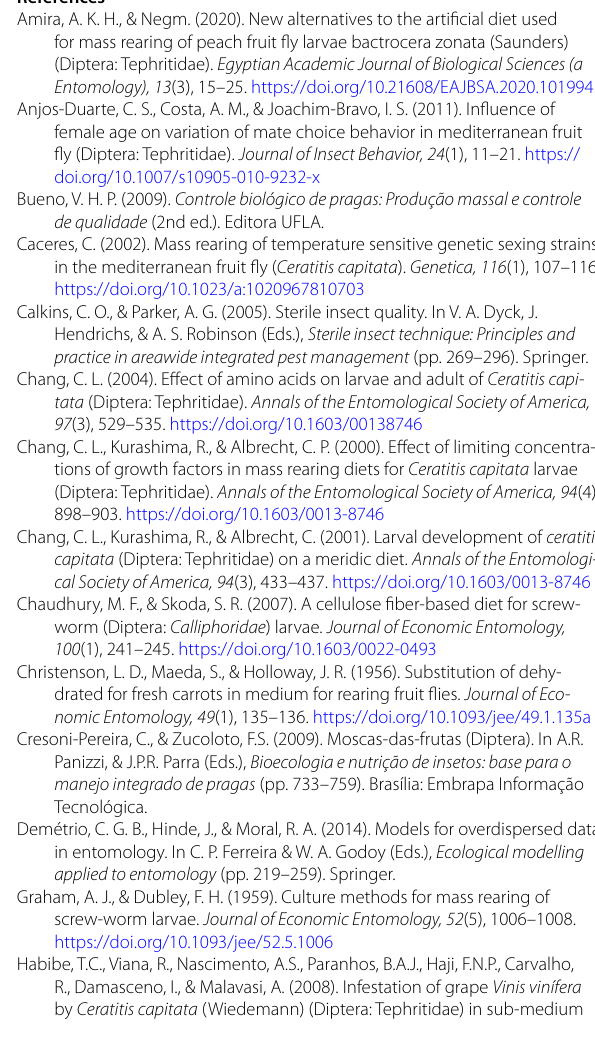
SB: based on sugarcane bagasse 3 CP: based on lyophilized carrot